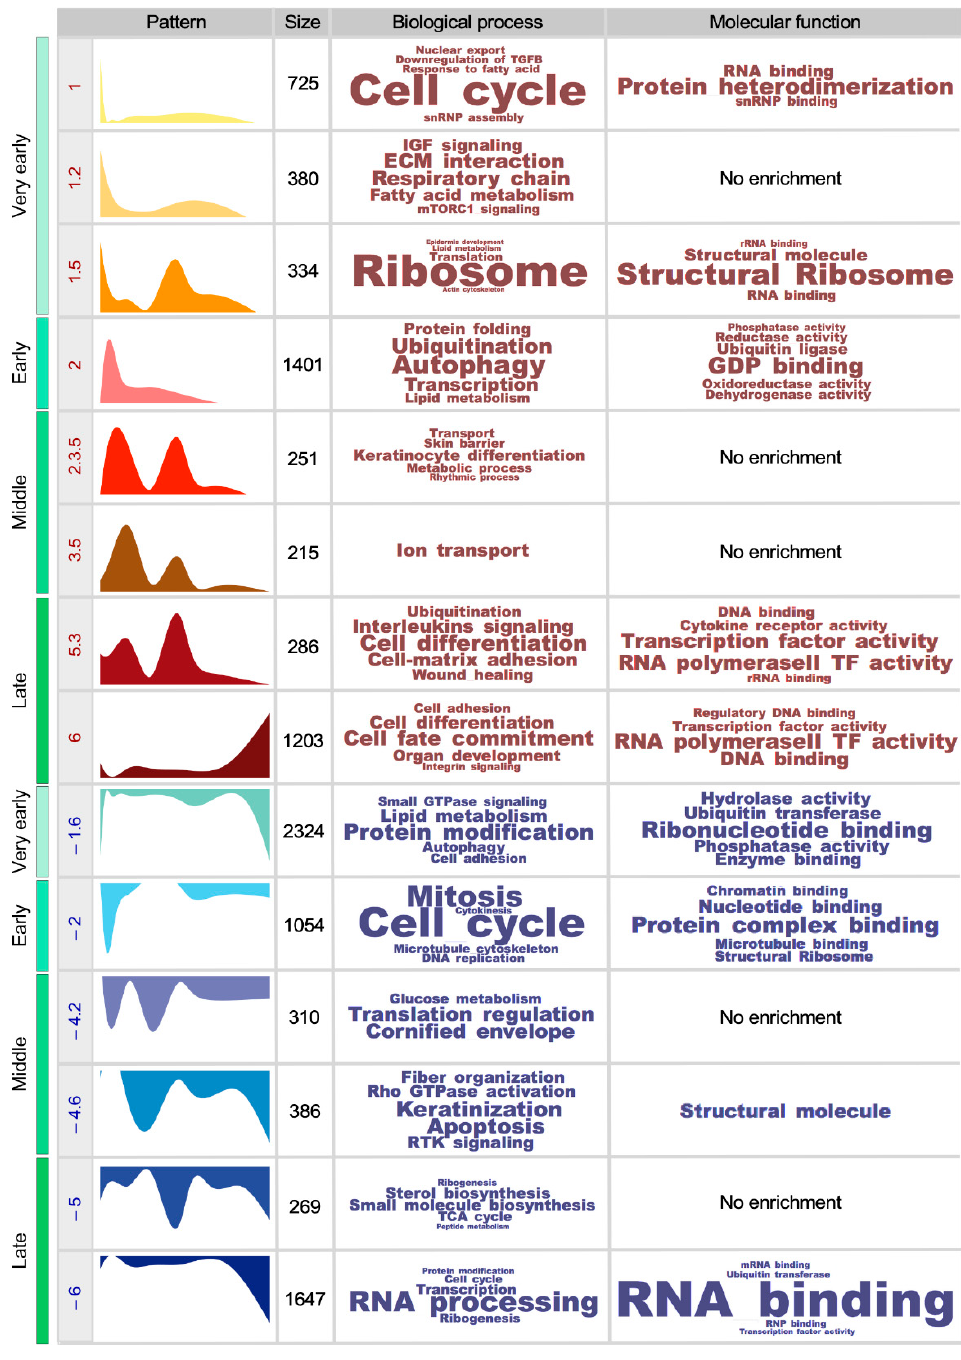
Figure 2. Time-driven expression patterns in mouse SSCs. Scheme showing the 14 nonredundant dynamic expression patterns found in this study. The table includes from left to right: (i) the experimental time-point (very early, early, middle, late) in which the indicated gene expression pattern is detected. (ii) The peak position (1 = 18-day-old, 2 = 30-day-old, 3 = 2.5-month-old, 4 = 4-month-old, 5 = 6-month-old, 6 = 12-month-old). (iii) The graphic representation of the indicated gene expression cluster. (iv) The number of probesets associated with the indicated gene clusters. (v) The top-enriched biological processes (with term size proportional to the − Log( P ) obtained for each of them). (vi) The top-enriched molecular functions (with term size proportional to the − Log( P ) obtained for each of them).